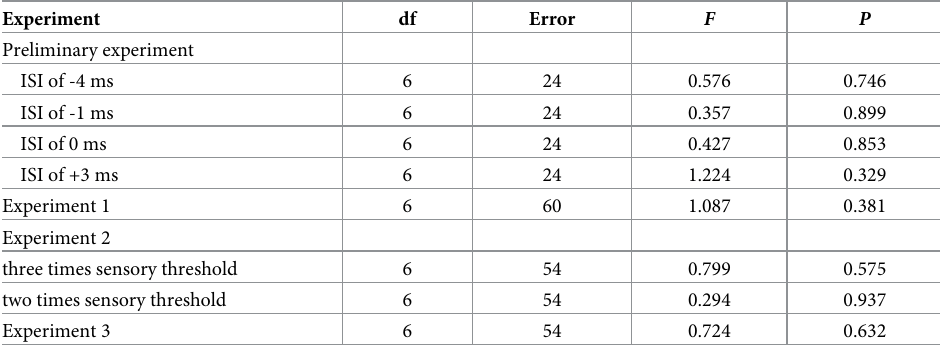
Table 2. Results of one-way rmANOVAs in background